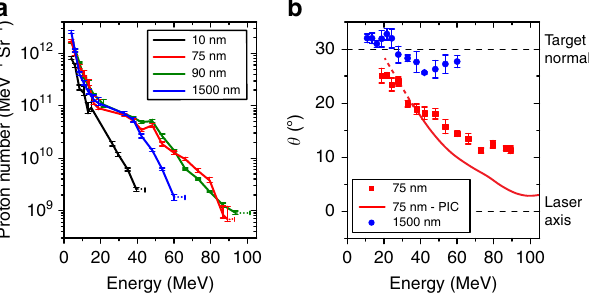
Fig. 2 Measurements of proton beam spectrum and direction. a Example proton energy spectra, as deconvolved from the RCF measurements, for given foil thickness, ‘ . The horizontal error bars at the maximum energy are de fi ned by the energy corresponding to the last RCF layer for which proton signal is measured (lower limit) and the energy of the next RCF layer (upper limit). The vertical error bars are de fi ned by the level of uncertainty in the calibration of the RCF. b Measured angle of the centre of the proton beam, θ , with respect to the laser axis (in the plane of the incident laser beam), as a function of energy, for ‘ = 75 nm (red) and 1.5 μ m (blue). The error bars are de fi ned by the uncertainty in determining the angle of the centre of the proton beam from application of a beam fi tting routine. An example PIC simulation result for ‘ = 75 nm (red curve) is included for comparison. The dashed lines mark the target normal and laser axis, for ease of reference